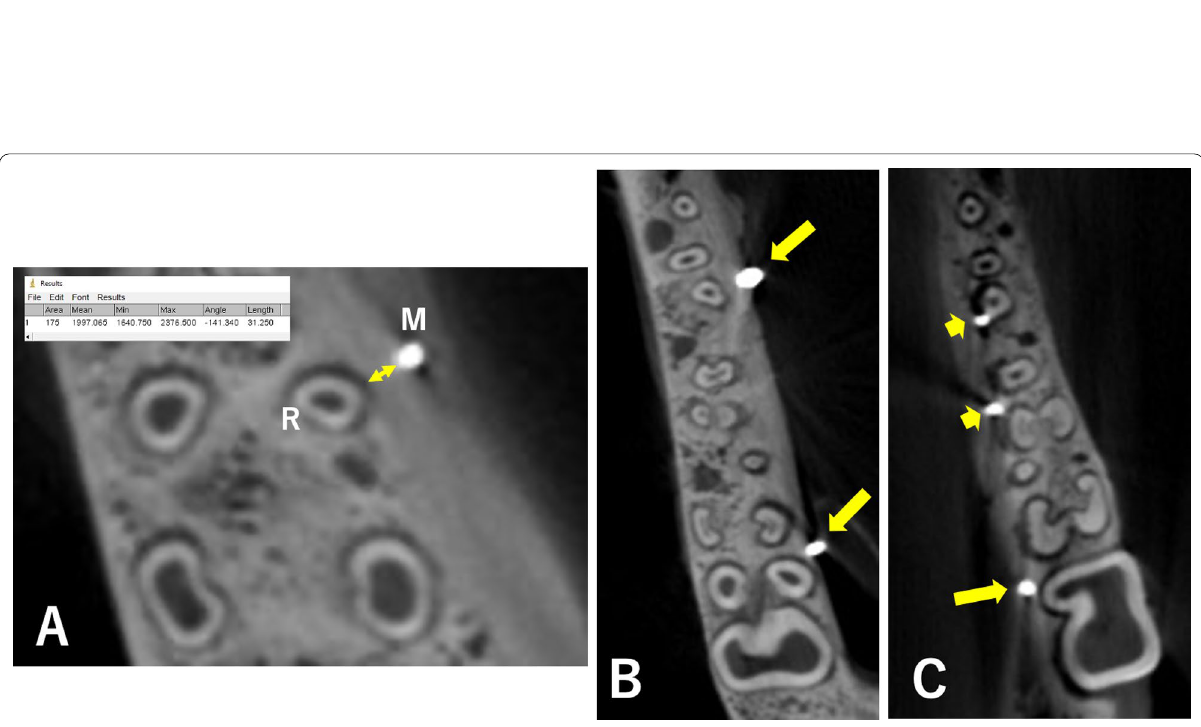
Fig. 2 Cross‑sectional cone beam computed tomography (CBCT) image showing how the distance ( A : yellow arrow line) between the miniscrew (M) and the root (R) was measured. CBCT image showing some miniscrews were some distance from the roots ( B , C : arrow), and some were close to the roots ( C :